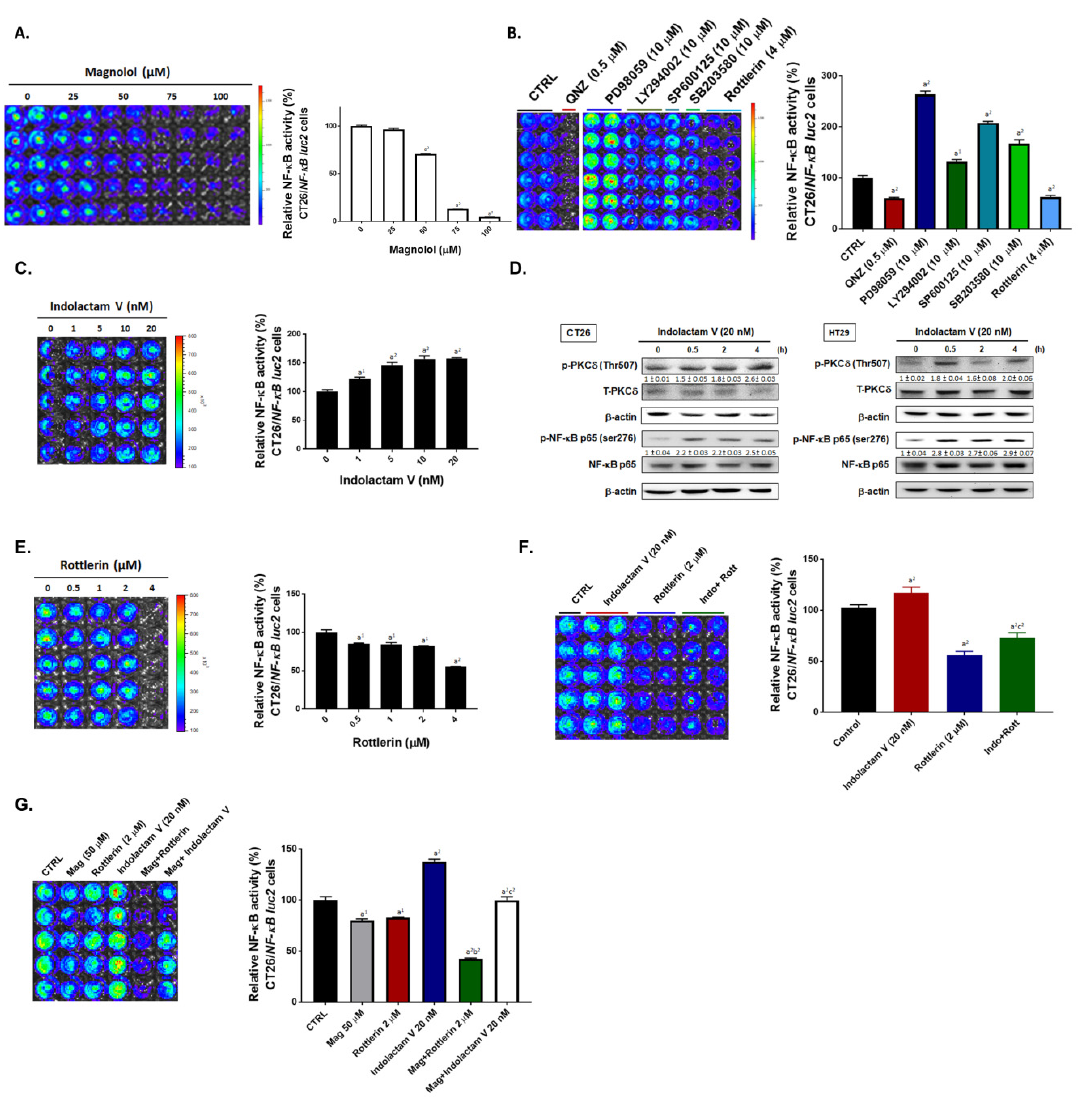
Figure 1. The activation of NF- κ B is suppressed by magnolol through inhibition of PKC δ signaling transduction in CRC cells. ( A ) NF- κ B reporter gene assay result after 0-100 μ M magnolol treatment is displayed by luminesce image and quantification bar chart. (a 1 p < 0.05 and a 2 p < 0.01 vs 0 μ M magnolol) ( B ) NF- κ B luminesce image and quantification bar chart after treated with 0.5 μ M QNZ (NF- κ B inhibitor), 10 μ M PD98059 (ERK inhibitor), 10 μ M LY294002 (AKT inhibitor), 10 μ M SP600125 (JNK inhibitor), 10 μ M SB203580 (p38 inhibitor) and 4 μ M Rottlerin (PKC δ inhibitor) is shown. (a 1 p < 0.05 and a 2 p < 0.01 vs non-treated control) ( C , D ) NF- κ B luminesce image, quantification bar chart and Western blotting results after treated with 0-20 nM Indolactam V (PKC activator). (a 1 p < 0.05 and a 2 p < 0.01 vs non-treated control) ( E–G ) NF- κ B luminesce image and quantification bar chart after or magnolol 50 μ M, 0–4 μ M Rottlerin, 20 nM Indolactam V or combined treatment. (a 1 p < 0.05 and a 2 p < 0.01 vs non-treated control; b 2 p < 0.01 vs Rottlerin single treatment; c 2 p < 0.01 vs Indolactam V single treatment).